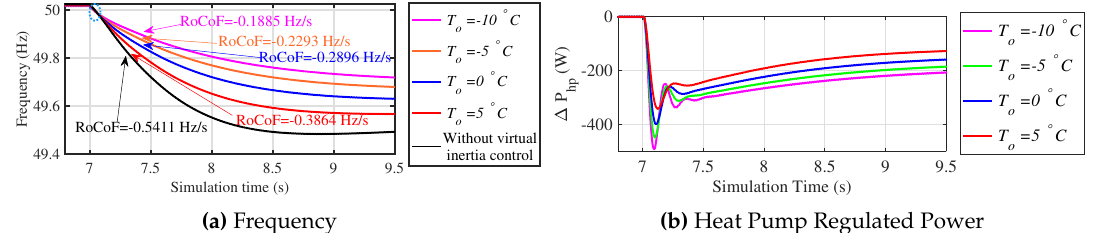
Figure 14. Response of the distribution system for different outdoor